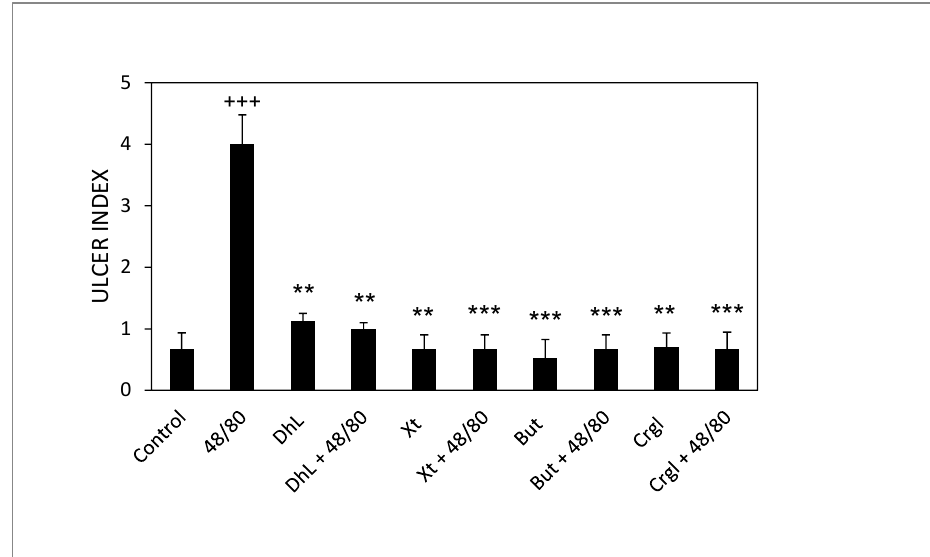
Figure 2. Images of the stomachs’ inner surface are seen under a stereoscopic magnifying glass. ( A ) control group (( G ) details of gastric roughness); ( B ) 48/80 group (( H ) details of gastric ulcer); ( C ) DhL + 48/80 group; ( D ) Xt + 48/80 group; ( E ) But + 48/80 group; ( F ) Crgl + 48/80 group (( I – L ) details of mild hyperemia). Black arrows: gastric ulcer. White arrows: mild hyperemia.